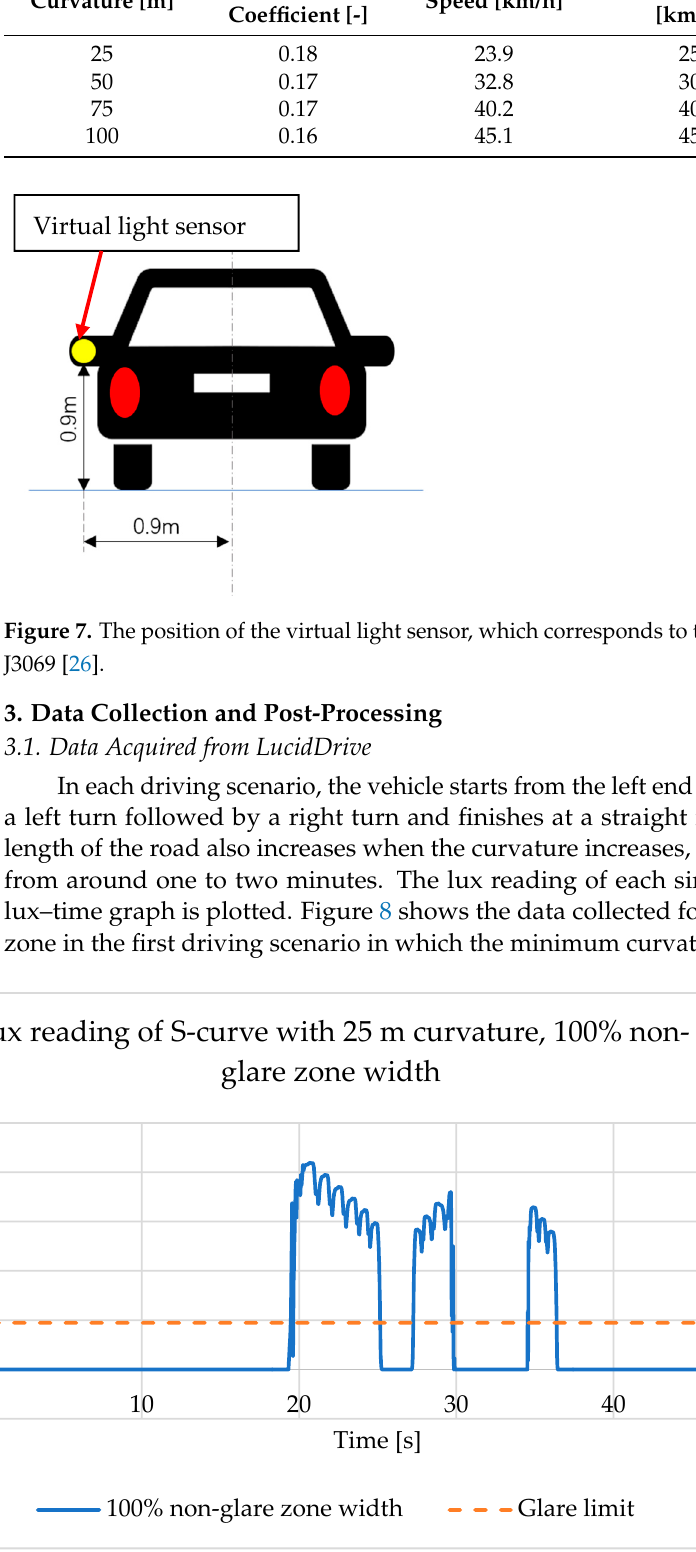
Figure 8. Lux reading of S-curve with 25 m curvature simulation at 100% non-glare zone width. The dashed line is 18.9 lux, above which is considered to be glare, according to both NHTSA [22] and SAE [26].